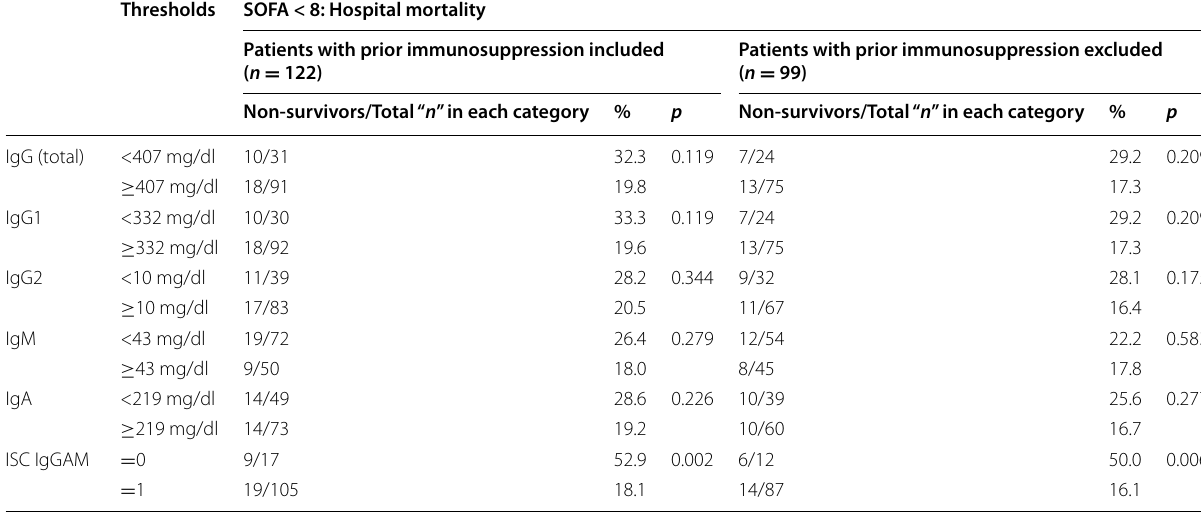
Table 4 Proportion of survivors and non-survivors at the hospital in the group of patients with SOFA score <8 depending on the immunoglobulin thresholds